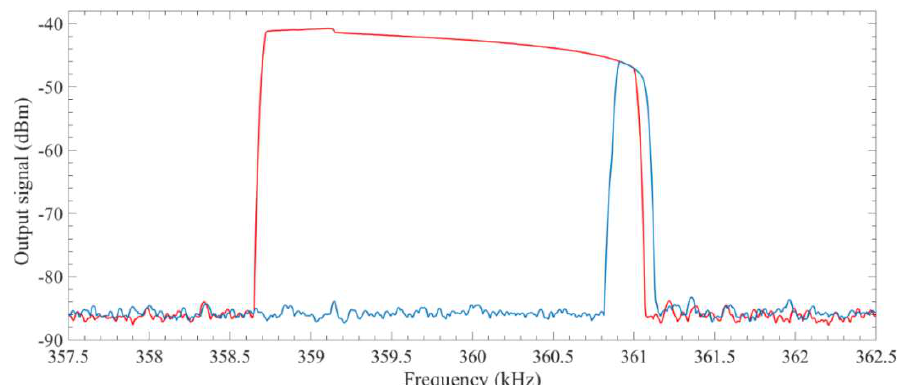
Figure 11. Forward (blue) and backward (red) frequency sweeps showing the nonlinear response of the system.